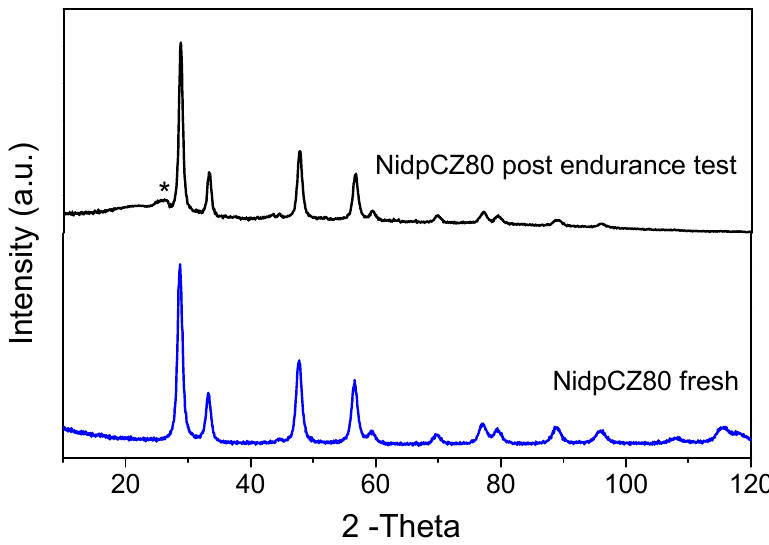
Figure 13. X ‐ ray diffraction spectra of NidpCZ80 catalyst, fresh and after endurance test.